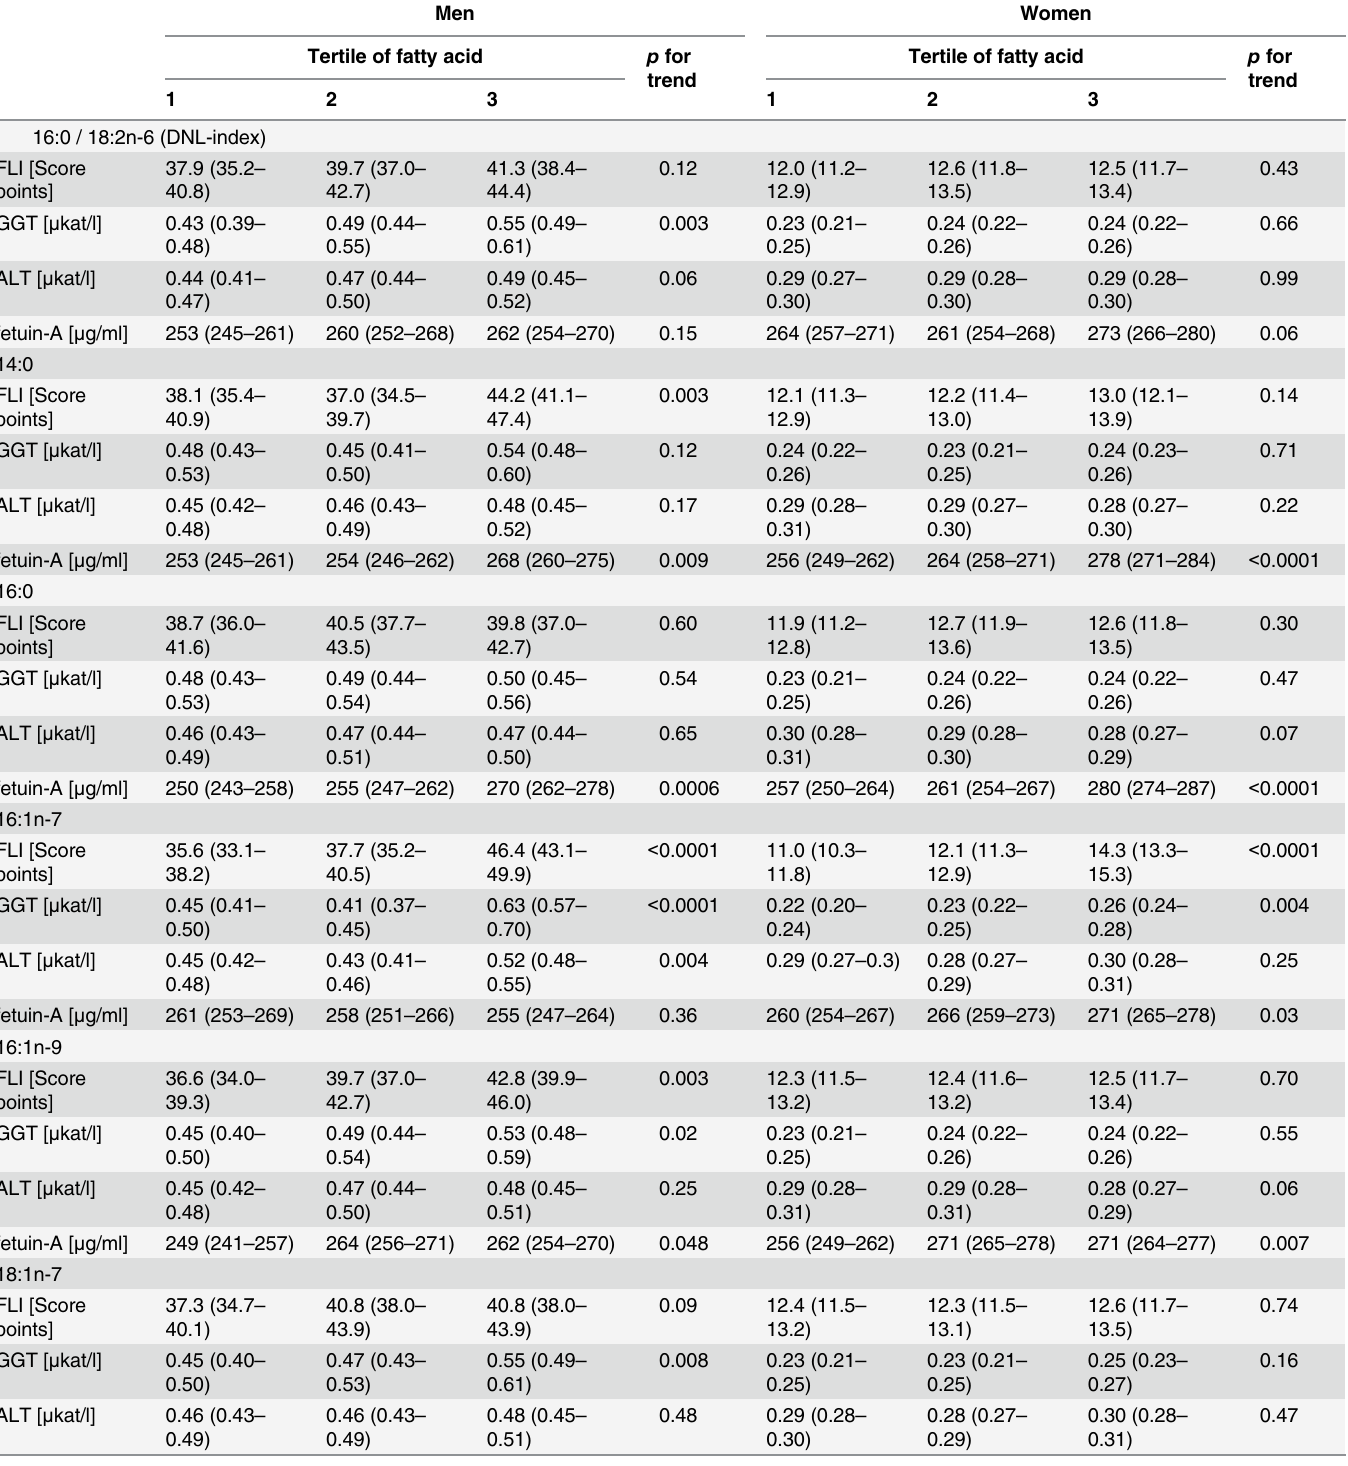
Table 3. Adjusted geometric means of the fatty liver index (FLI), plasma GGT and ALT and adjusted arithmetic means (95% CI) of plasma fetuin-A by tertiles of erythrocyte FA proportions for men (n = 573) and women (n = 989), EPIC-Potsdam study a . Men Women Tertile of fatty acid p for Tertile of fatty acid p for trend trend